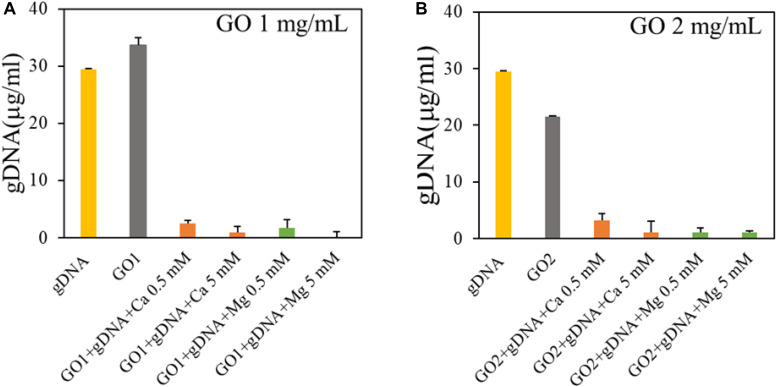
Analysis of binding of GO with genomic DNA in the presence of GO at 1 mg/ml (A) or GO at 2 mg/ml (B). Concentration of DNA in supernatants is reported after UV spectroscopic analysis.